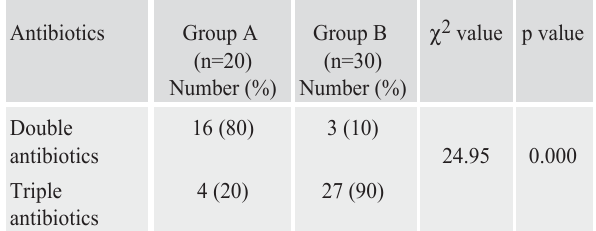
Table V: Frequency of use of